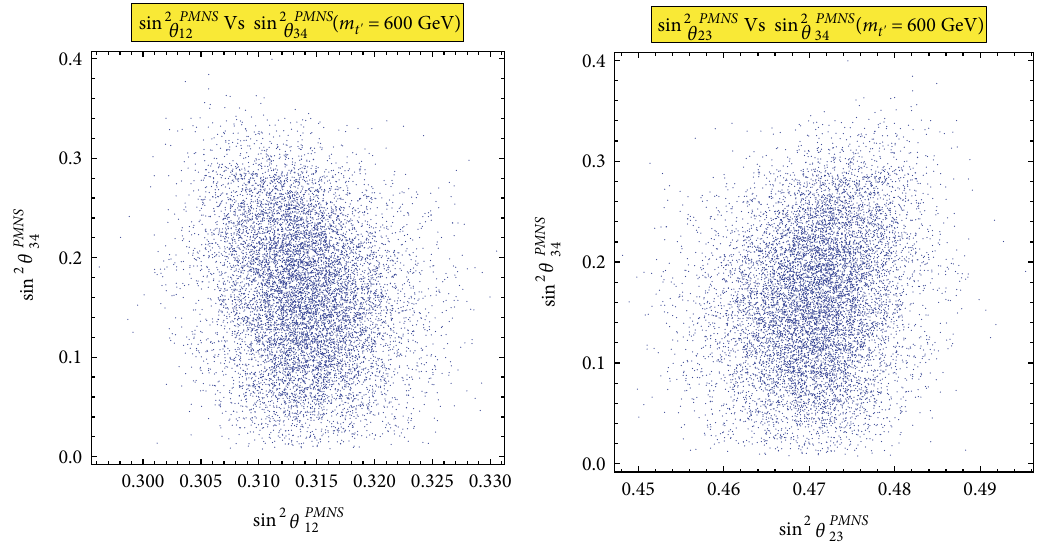
Figure 4: Correlation plot for sin 2 𝜃 𝑃𝑀𝑁𝑆